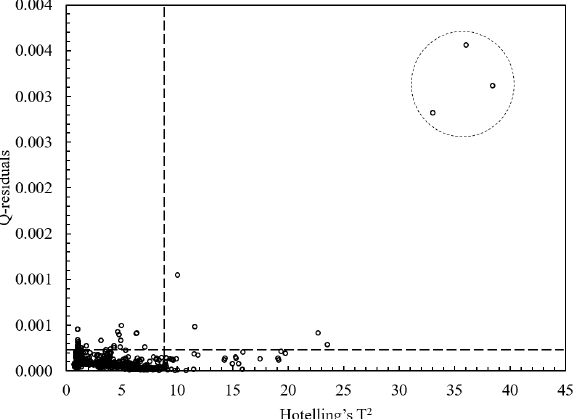
Figure 4. A plot of Hotelling’s T 2 versus Q-residual of honey samples using the third principal component (PC3) from PCA (principal component analysis) calculation at the 95% significance level.